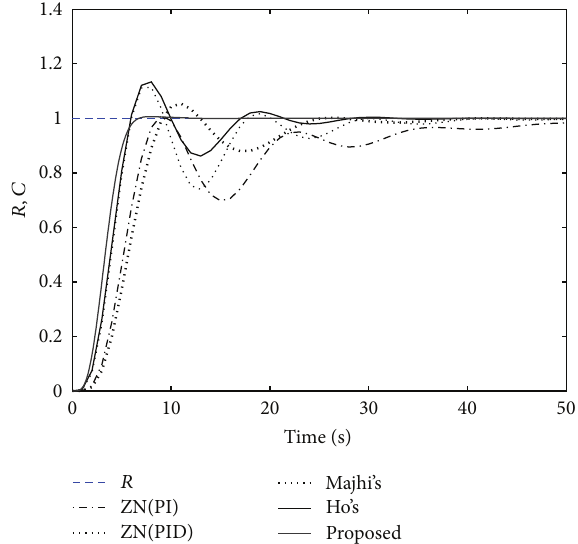
Figure 13: Comparisons with other methods for Example 2.